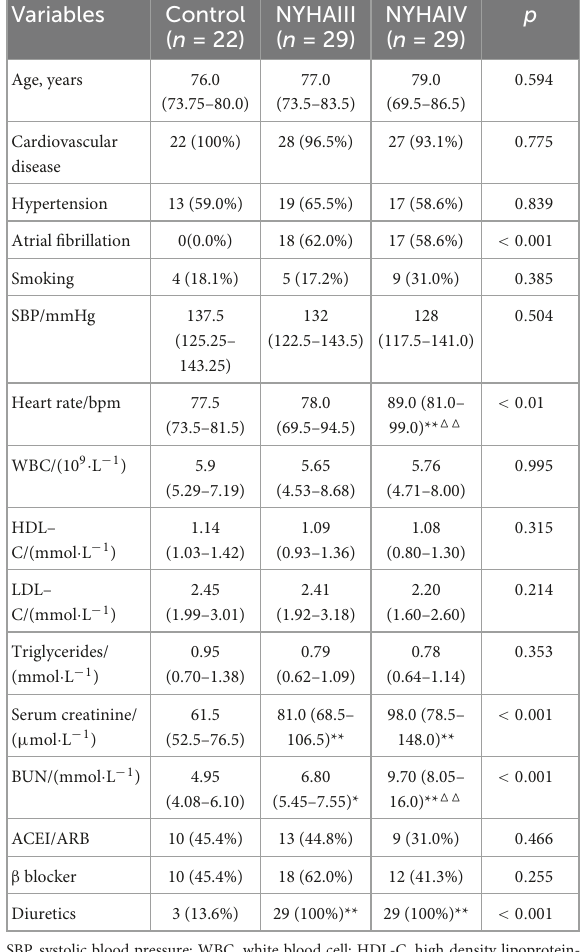
TABLE 1 Baseline characteristics of the study